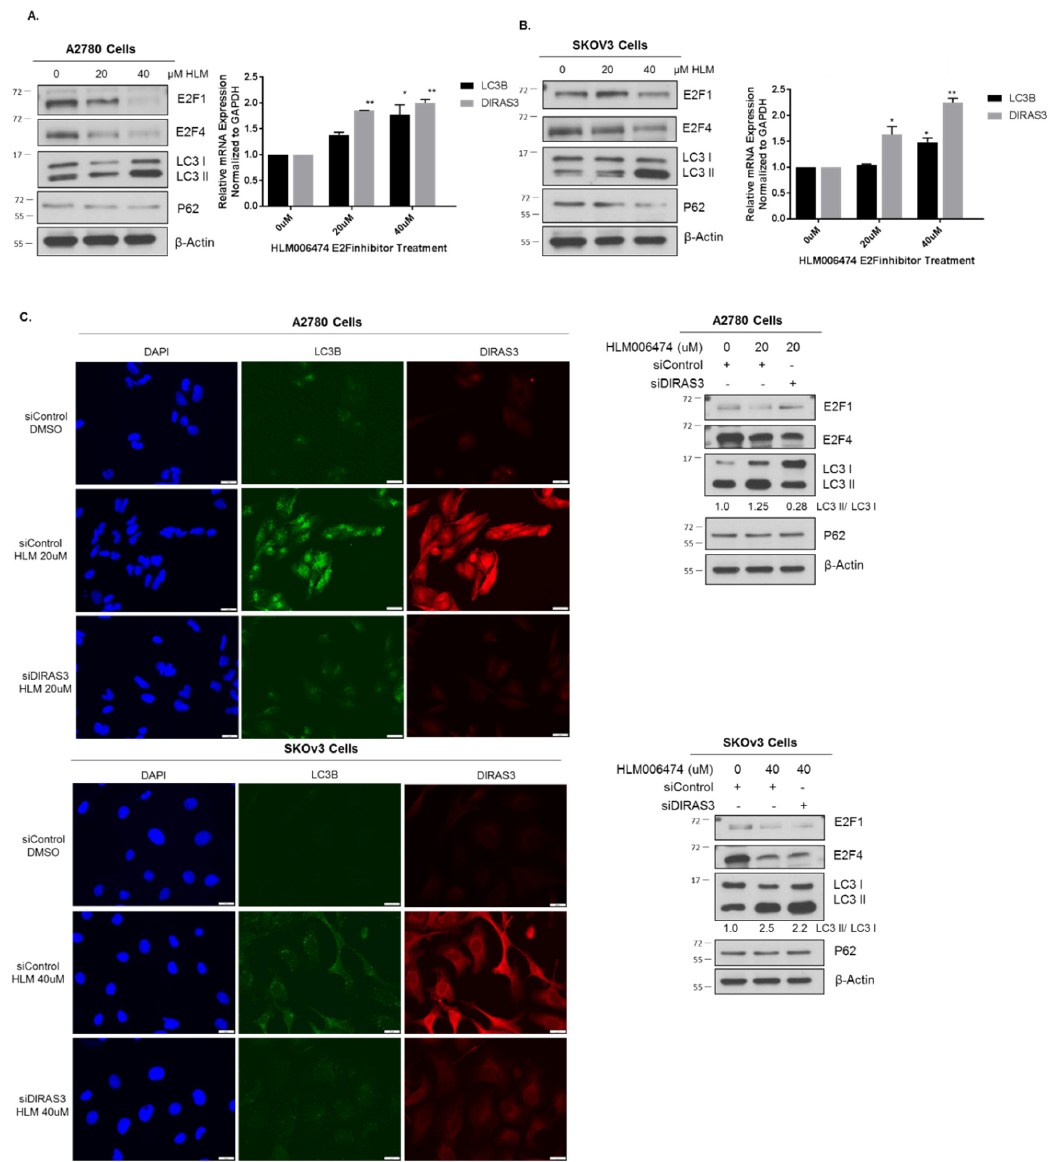
Figure 6. Pharmocologic inhibition of E2F1 / 4 induces DIRAS3-mediated autophagy. A2780 ( A ) or SKOv3 ( B ) ovarian cancer cells were seeded at 0.3 × 10 6 cells / well in a 6-well plate and treated with 20–40 µ M HLM006474 for 24 h. Protein lysate was collected for western blot analysis and probed as indicated. RNA was extracted and qRT-PCR was performed to measure DIRAS3 and MAPLC3B mRNA expression compared to GAPDH. The experiment was performed three independent times with technical duplicates. Bars indicated the mean ± the standard deviation; * p < 0.05 and ** p < 0.01. (C) A2780 and SKOv3 cells were treated with control or DIRAS3 siRNA for 48 hprior to treatment with 20–40 µ M HLM006474 for 24 h. Immunofluorescence staining and western blot analysis was performed as indicated. Knockdown of DIRAS3 inhibited HLM006474-treatment induced autophagy. Raw data films for western blot analysis shown in Figure